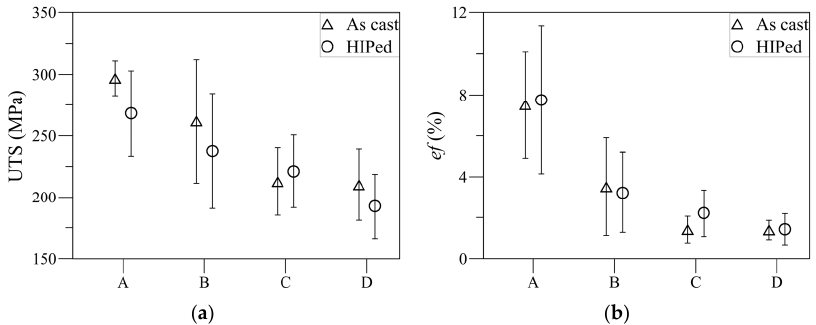
Figure 14. Mechanical properties of as ‐ cast and HIPed samples where ( a ) is showing the variation in UTS and ( b ) is shows the variation in e f . Error bars are showing one standard deviation. After tensile testing the density of samples were measured and related to mechanical properties.